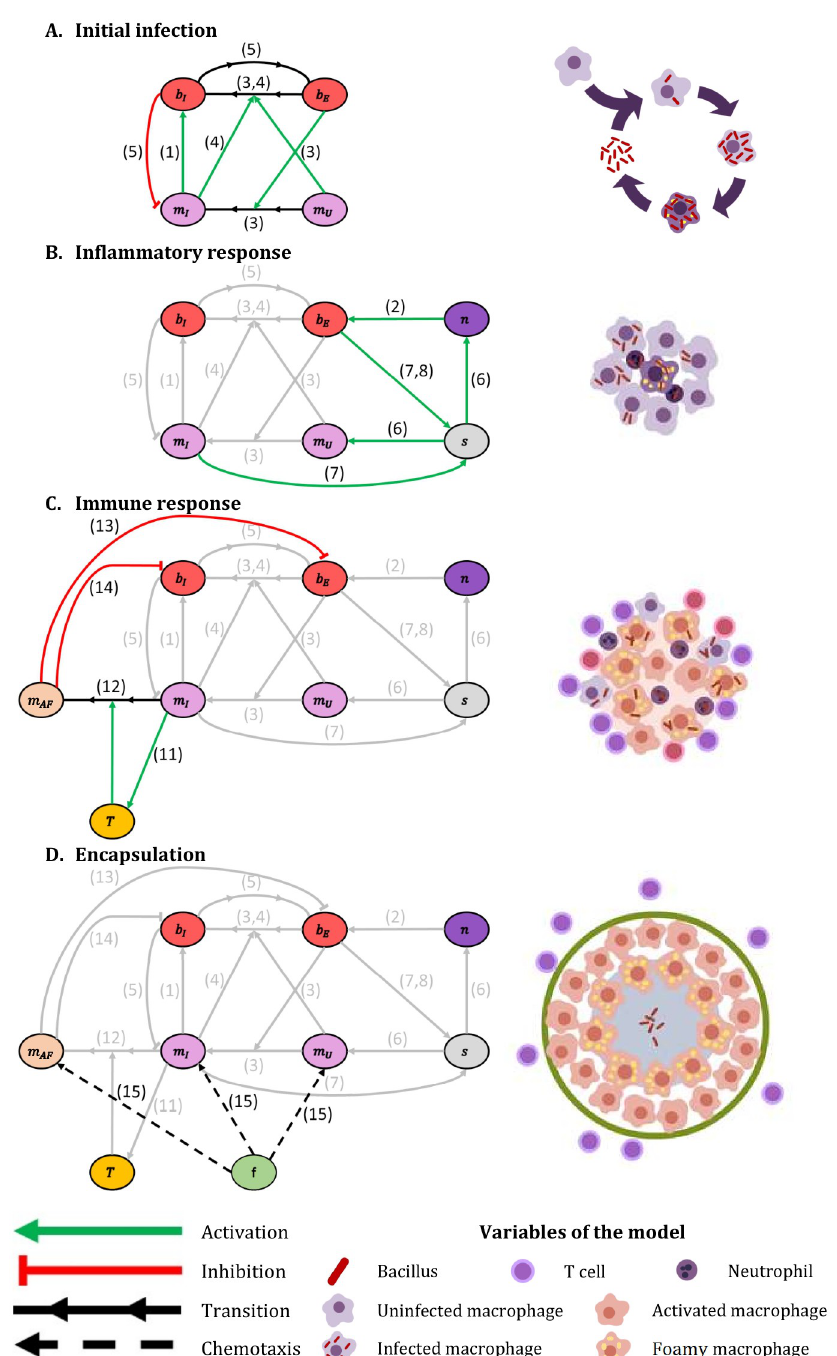
Fig 1. Four principal model’s modules. Interaction between different model elements. (A) Initial infection: interaction between bacilli and macrophages. (B) Inflammatory response: triggered by the presence of extracellular bacilli. (C) Immune response: infected macrophages trigger the mechanisms that activate this response. (D) Encapsulation: led by fibroblasts, it takes place when a lesion makes contact with a pulmonary membrane. Green arrows: activation; red arrows: inhibition; black arrows: transition; dotted arrows: chemo-taxis. Numbers identify specific processes: 1 intracellular bacilli growth, 2 extracellular bacilli growth, 3 phagocytosis by non-infected macrophages, 4 phagocytosis by infected macrophages, 5 macrophages’ lysis, 6 inflammatory response entrance, 7 inflammatory response activation, 8 inflammatory response inhibition, 11 immune response entrance, 12 macrophages activation, 13 extracellular bacilli elimination, 14 intracellular bacilli drainage and 15 fibroblasts chemo- taxis. See model’s details in Eqs (1)–(10). Part of this figure is adapted from [6].